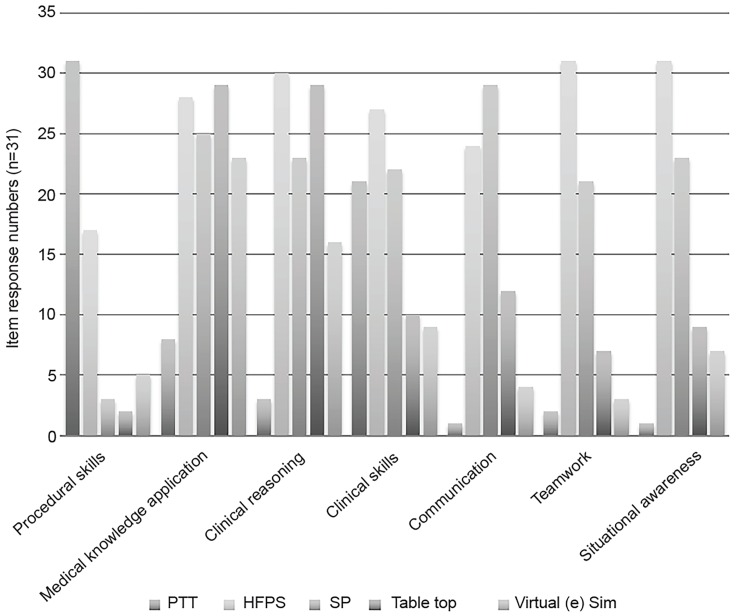
Simulation modalities best suited to specific deficiencies.PTT, partial task trainers; HFPS, high fidelity patient simulators (mannequins); SP, standardized patients.Tabletop: oral board-style simulations; Virtual (e) Sims Online web-based virtual simulations.